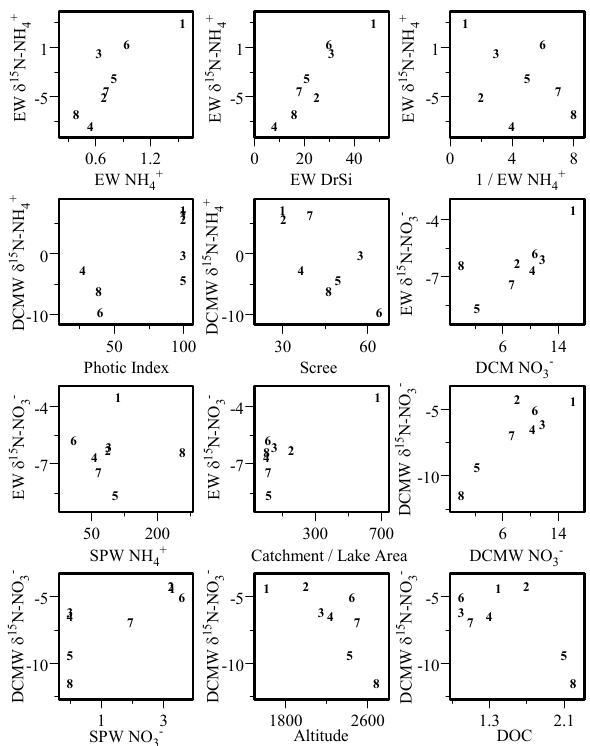
Fig. 3. Relationships between δ 15 N-NO − epilimnetic water (EW) and deep chlorophyll maximum wa- ter (DCMW), and different lake variables. The eight Pyrenean lakes studied are numbered according to Table 1. δ 15 N values are ex- pressed in ‰, concentration of ammonium (NH + and dissolved reactive silica (DRSi) in µmolL − 1 , photic index and scree in %, altitude in ma.s.l. and dissolved organic carbon (DOC) in mgL − 1 .